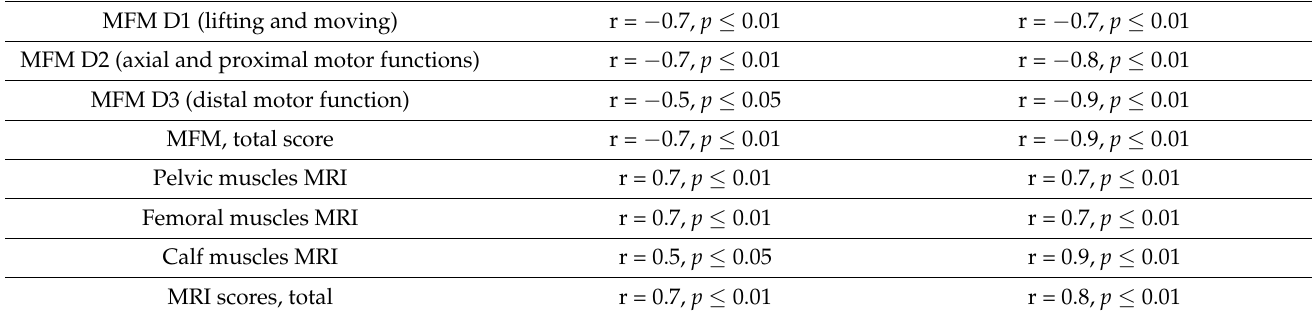
Table 5. Correlation analysis (r Spearman ) of the age of patients capable and not capable of independent movement with the results of the assessment according to the MFM scale and MRI data. Age of Patients without the Ability to Age of Patients with Intact Mobility Move